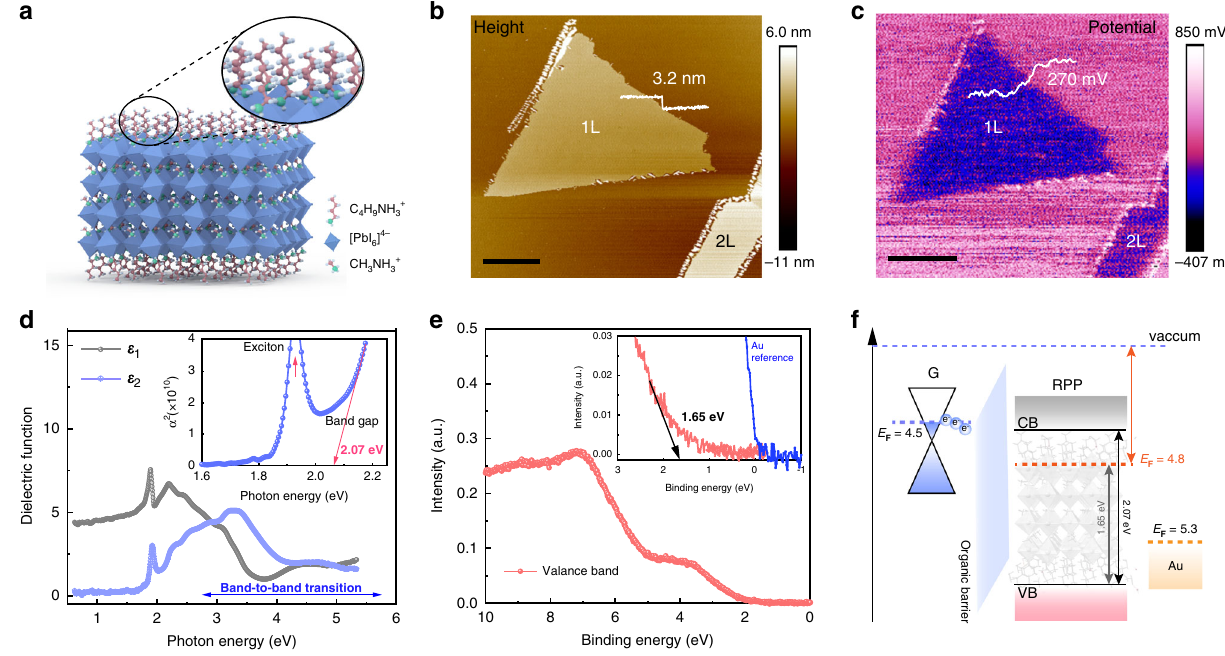
Fig. 1 Spectroscopic analysis of Fermi level and band edges in Ruddlesden-Popper perovskite (RPP) relative to graphene (G) and gold (Au). a Structural illustration of monolayer n = 4 RPP ((C 4 H 9 NH 3 ) 2 (CH 3 NH 3 ) 3 Pb 4 I 13 ). b Atomic force microscopy (AFM) image of monolayer and bilayer n = . 4 RPP fl akes exfoliated on pure silicon substrate. Scale bar, 1 µ m. c Corresponding Kelvin probe force microscopy (KPFM) on the same area of ( b ). Scale bar, 1 µ m. d Real ( Ɛ 1 ) and imaginary ( Ɛ 2 ) components of the dielectric function for n = 4 RPP; inset shows the extrapolated electronic gap. e Valence band spectroscopy of n = 4 RPP showing valence band edge. f Interfacial energy alignment diagrams of n = 4 RPP, G and